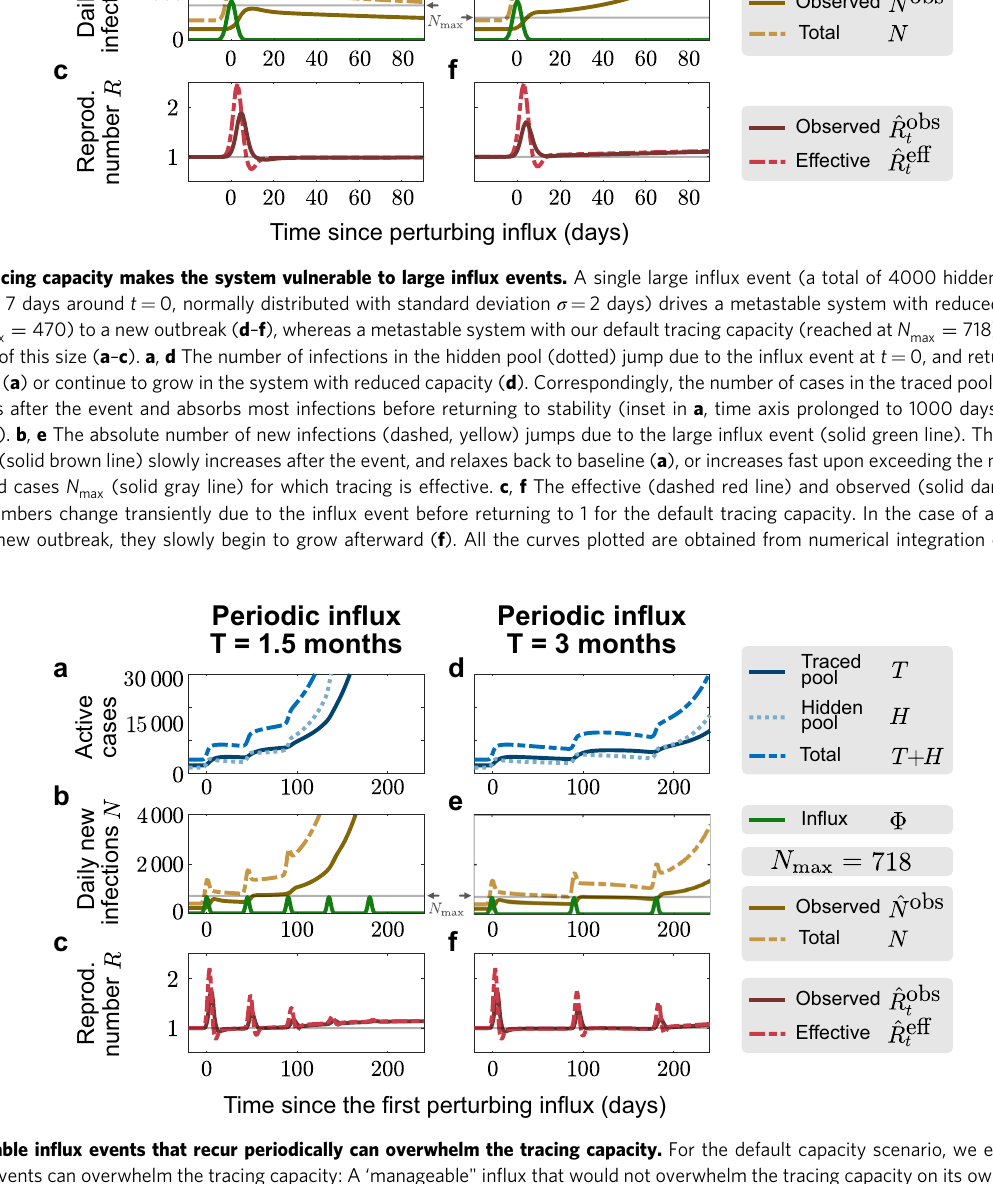
Both the initial change in the hidden reproduction number and the breakdown of the tracing system are re fl ected in the observed ^ , (Fig. 6c). It transits from stability reproduction number R obs t t ^ ^ ¼ 1) to instability ( R obs > 1). However, the absolute values ( R obs t t